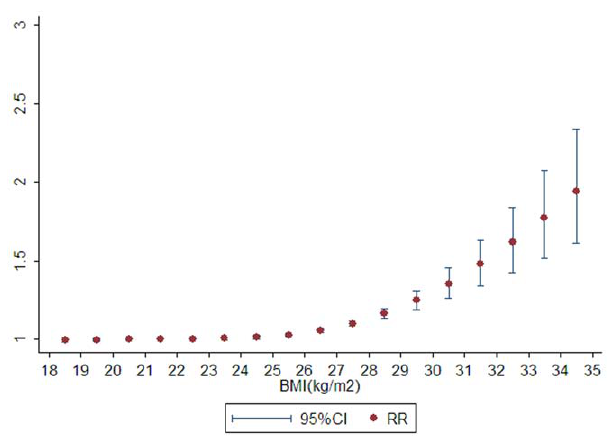
Figure 3. The curve of body mass index and relative risk of liver cancer in Asian